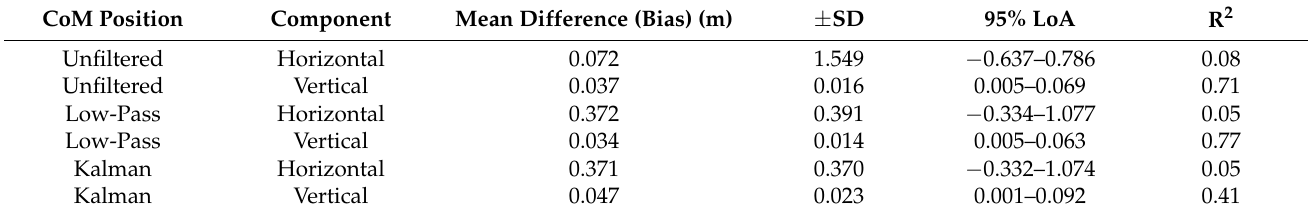
Table 3. Between system comparison of CoM position during pushing.